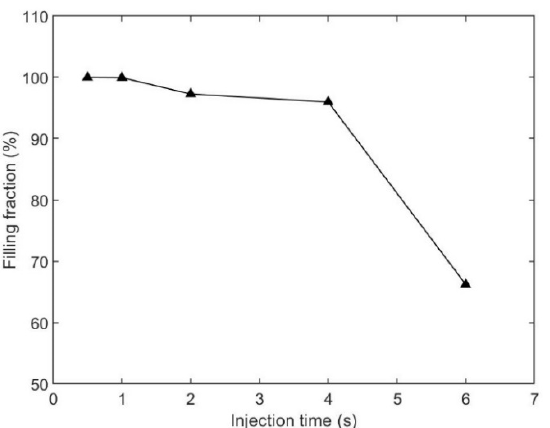
Figure 3. Relationship between the injection time and filling fraction, based on Table 3.